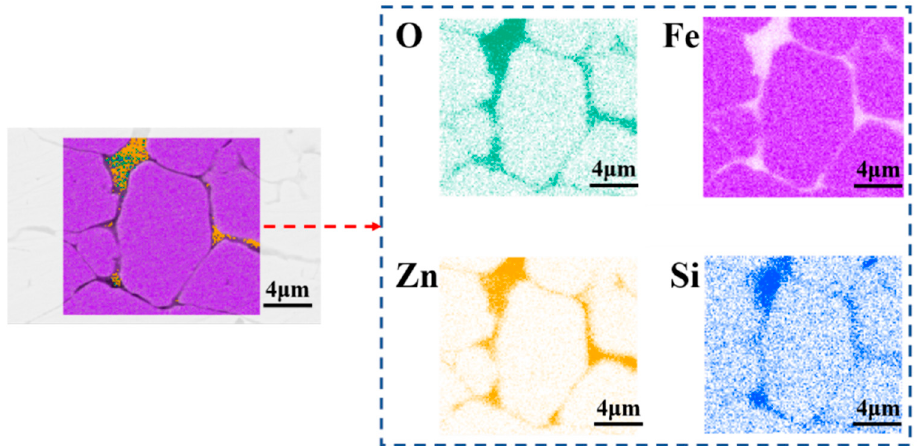
Figure 5. EDS spectra of polished cross-section samples coated with 5 wt.% KH550 + Zn(C 2 H 5 ) 2 + C 6 H 14 .